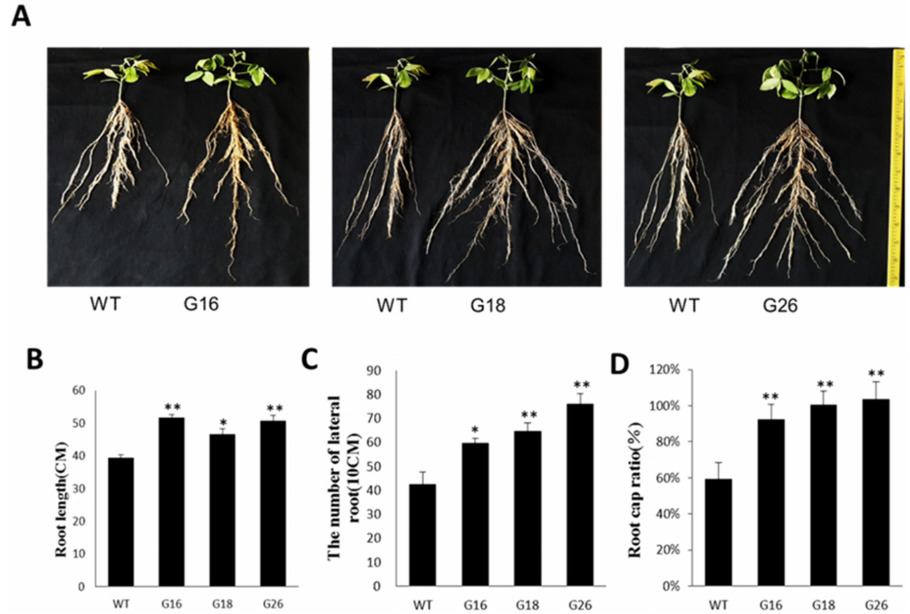
Figure 6. Identification of root growth and root–top ratio of the transgenic soybean. Seeds of three transgenic lines and non-transgenic control plants were planted in different plastic bags in a greenhouse under normal conditions for 6 weeks. *: p -value ≤ 0.05; **: p -value ≤ 0.01; G16, G18,